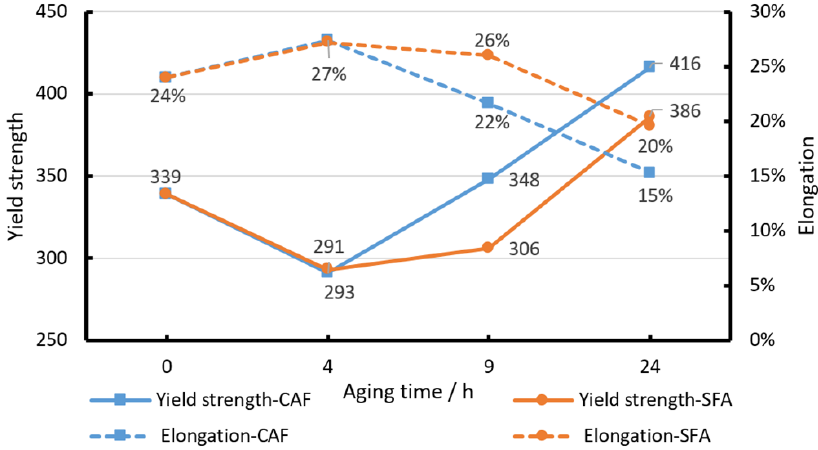
Figure 8. Yield strength and elongation of AA2524 under creep age forming and artificial aging.